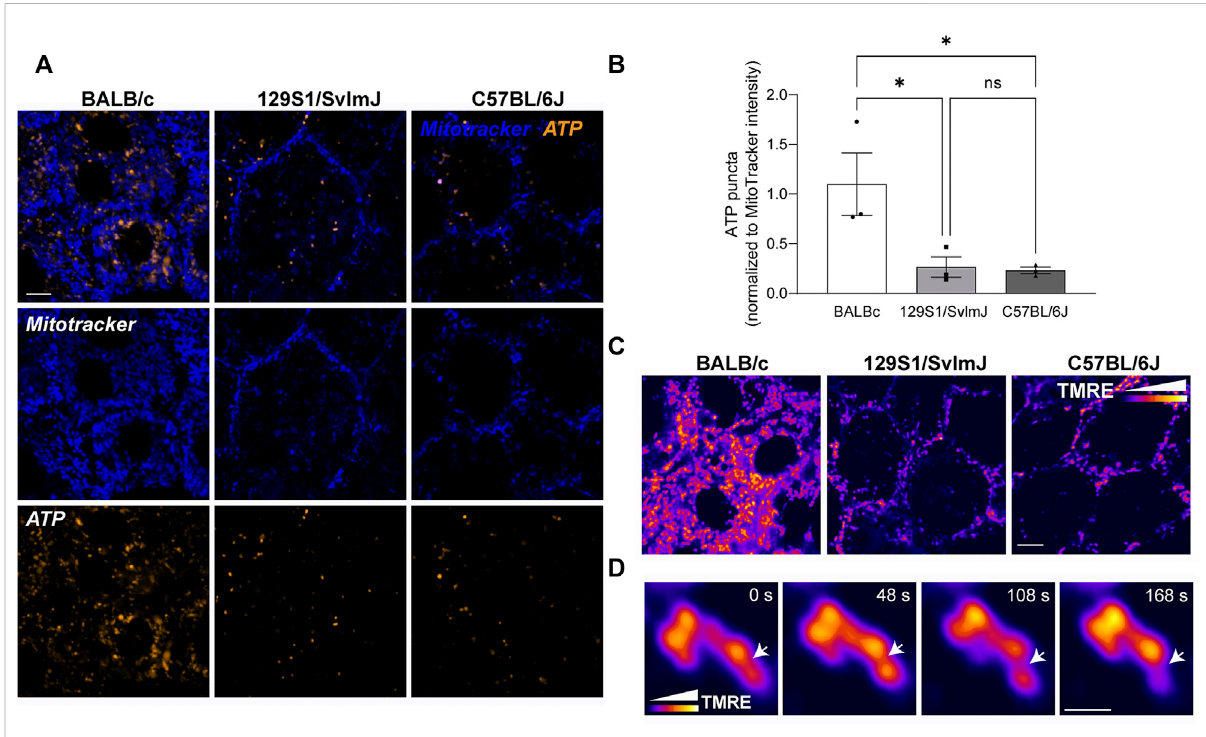
FIGURE 6 Genetic background of wildtype mice determines mitochondrial integrity and function in the RPE. (A) Stills from live imaging of mitochondria (Mitotracker, blue) and BioTracker-ATP (gold) in albino BALB/c, pigmented 129S1/SvlmJ, and pigmented C57BL/6J mouse RPE fl atmounts. (B) Quantitation of ATP puncta normalized to Mitotracker intensity. Mean ± SEM. n = 3 mice per strain. * p = 0.0497 between BALB/c and 129S1/SvlmJ; p = 0.0427 between BALB/c and C57BL/6J by one-way ANOVA. (C) Mitochondrial membrane potential (MMP) measured by TMRE labeling in mouse RPE fl atmounts. Color scale depicts relative intensity of TMRE. Scale bar = 3 µM. (D) High magni fi cation images showing local heterogeneity of MMP within a single mitochondrion. Note that areas of low TMRE intensity predict putative fi ssion sites (arrow). Scale bar = 1 µM. Also see Supplementary Movies